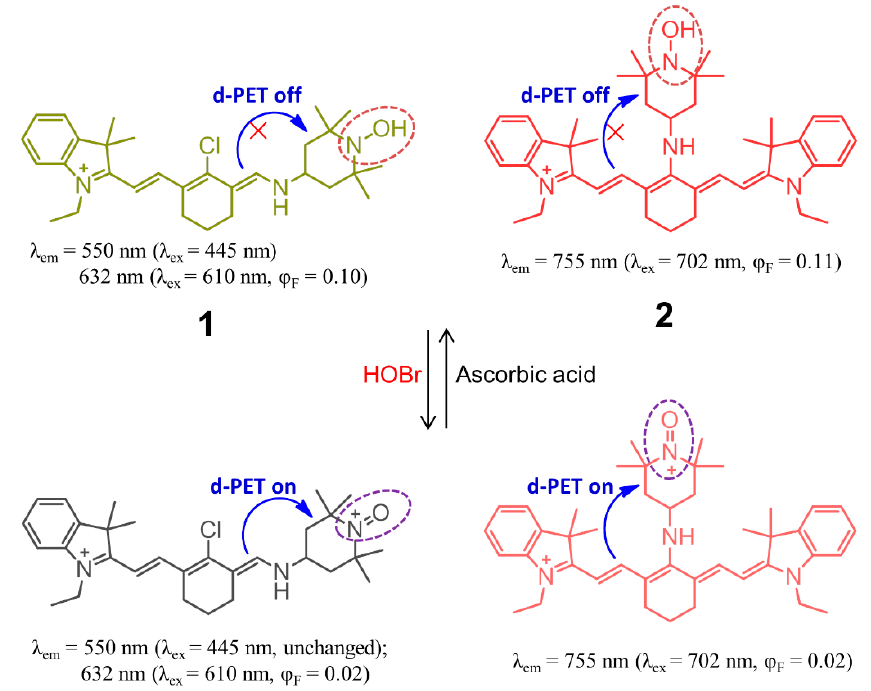
Figure 3. Chemical structures of cyanine-based fluorescent probes 1 and 2 for selective recognition of HOBr.